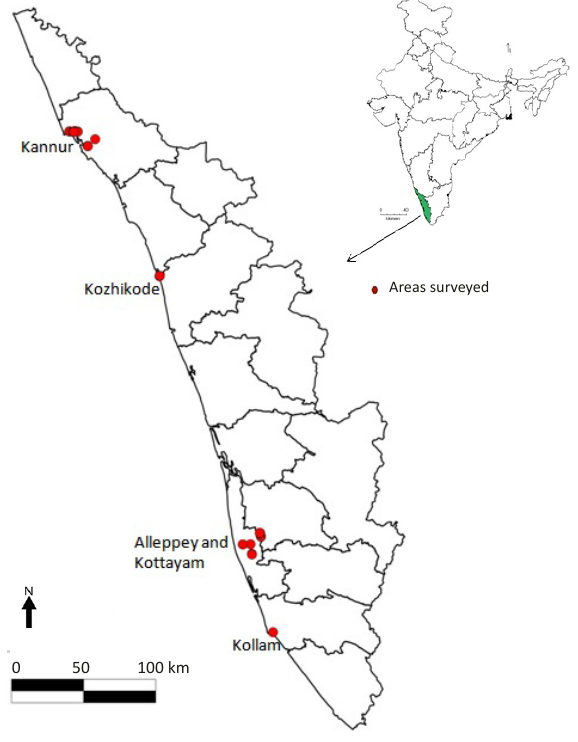
Figure 1. Map showing the areas surveyed in Kerala The inset shows the map of India with Kerala state highlighted. The name of the districts is mentioned in the map and the points in red are the localities studied during the survey. Source: Data extracted from GADM version 1.0